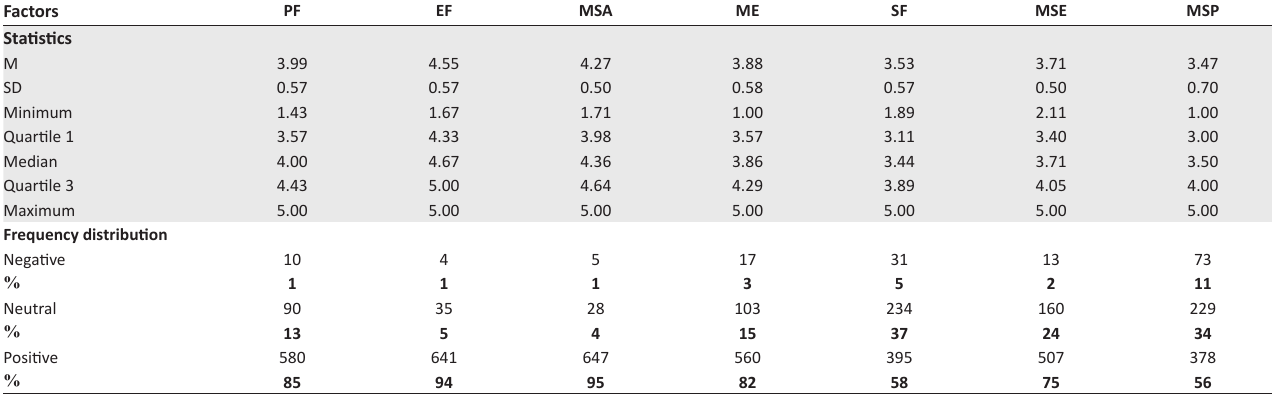
TABLE 5: Descriptive statistics for the factors ( n = 680). Factors PF EF MSA Statistics